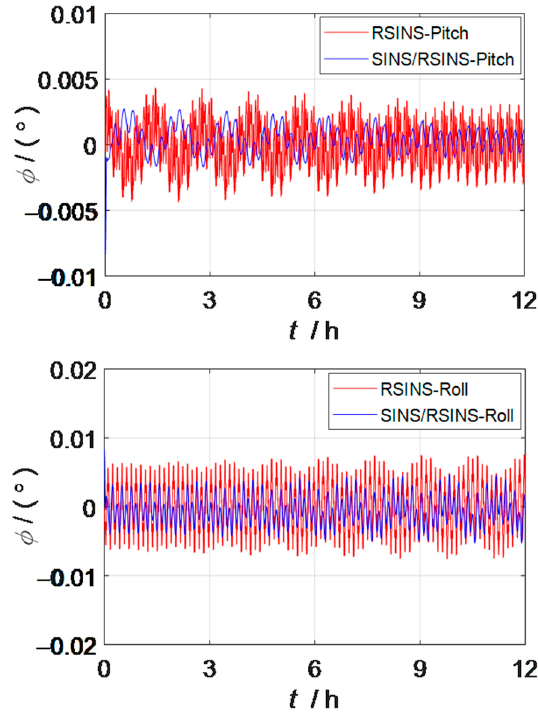
Figure 6. Comparison curve of dual INS combination scheme and RSINS horizontal attitude error.